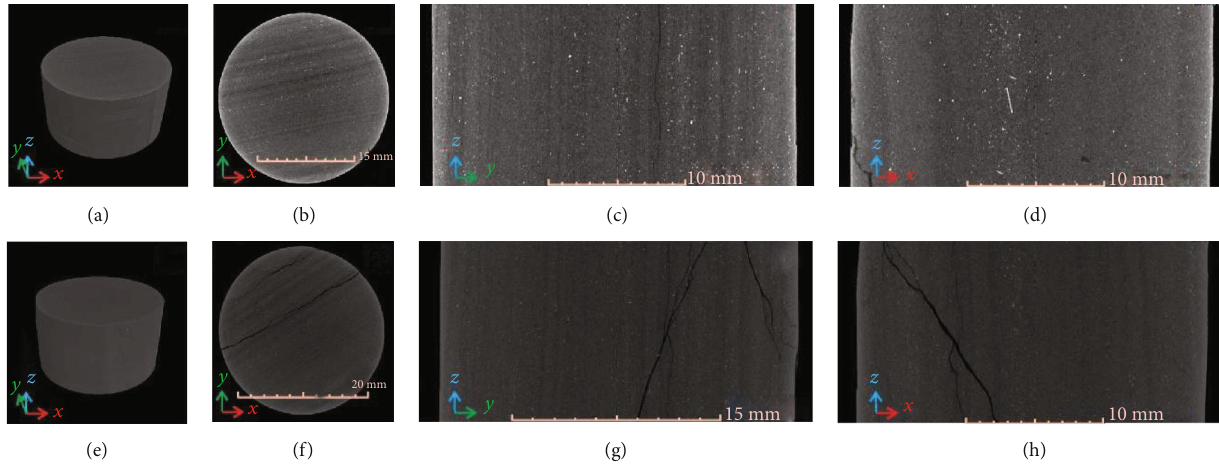
Figure 7: 3D CT images before sample 11 being pressed and after being pressed. (a – d) 3D CT images before sample 11 being pressed. (e – h) 3D CT images after sample 11 being pressed.